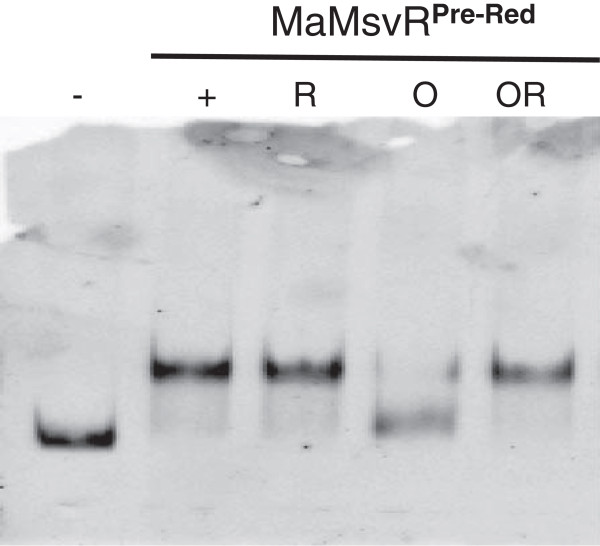
Proposed Mechanism for Redox-Sensitive Transcriptional Regulation by MaMsvR. EMSA experiment with pre-reduced MaMsvR and various treatments. The PmsvR DNA (10 nM) only control reaction is represented by (-). All other lanes contain PmsvR DNA (10 nM) and 200 nM MaMsvRPre-Red either in the absence (+, O) or presence (R, OR) of 5 mM DTT. Lanes labeled with (O) also contain 10 μM H2O2.